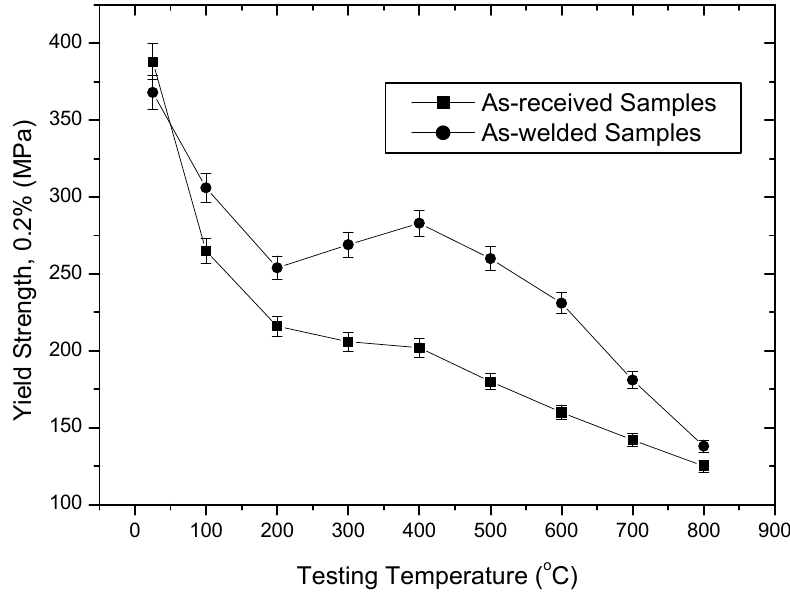
Figure 3. Yield strength values of the as-received and as-welded samples tested at different temperatures.